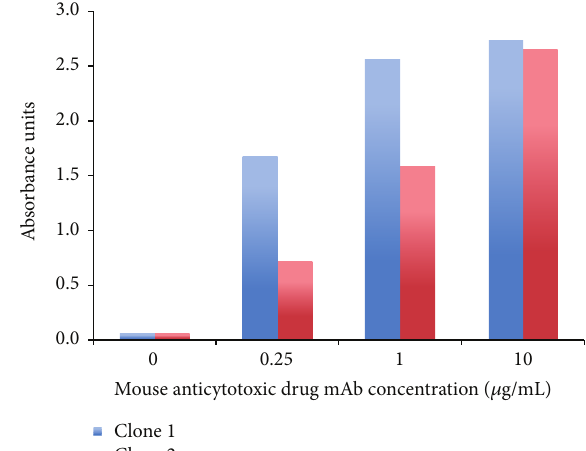
Figure 6: The generic assay detects ADAs against the linker- cytotoxic drug domain of an ADC. Two mouse anticytotoxic drug mAbs at various concentrations were spiked in pooled cynomolgus monkeyserumwithADCC(5 𝜇 g/mL).Thereactivityoftheimmune complexes was measured in a generic assay model: the ADA-ADC complexes were captured on a sheep anti-human IgG-coated plate and for detection an anti-mouse IgG-HRP antibody was used. Positive responses were obtained with the two mAb clones at all the concentrations tested. ADA = anti-drug antibody; mAb = monoclonal